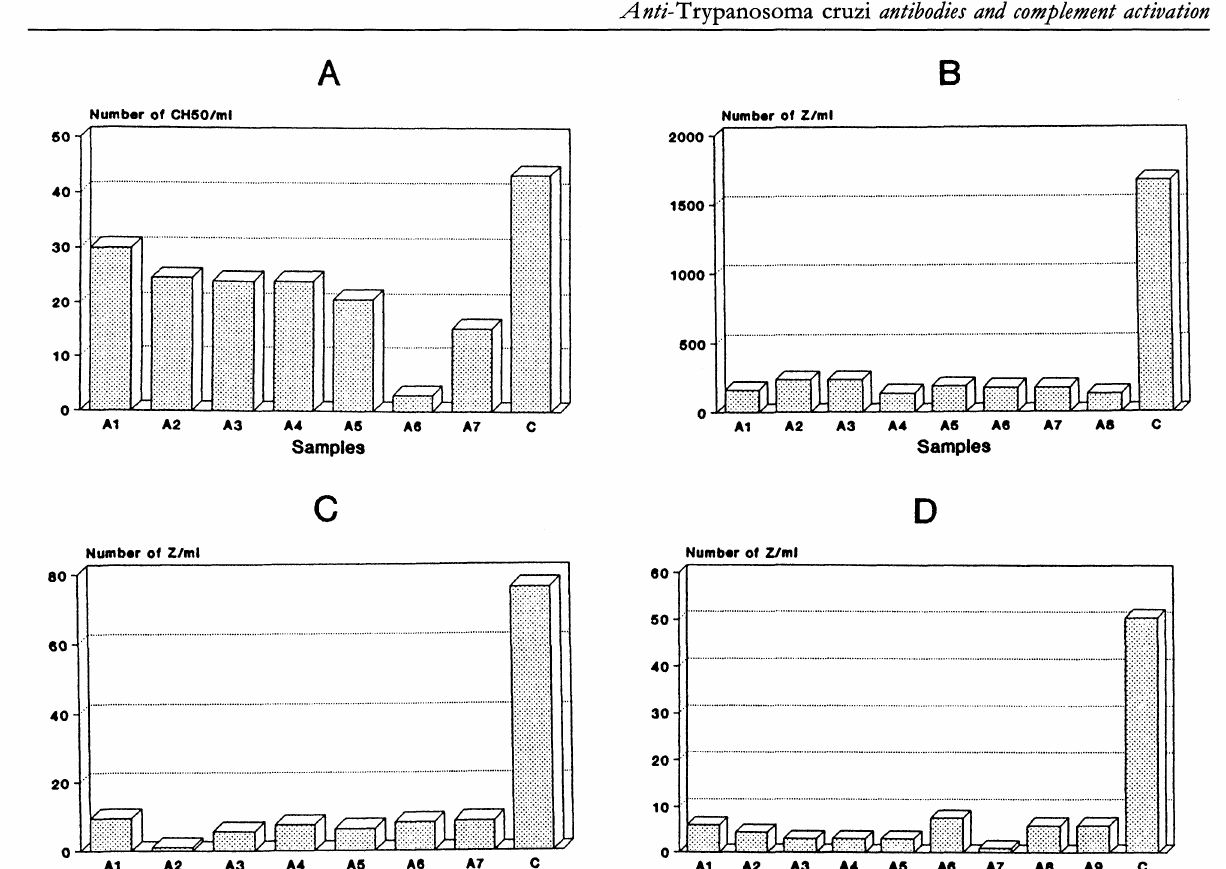
Fig. 1. Activation of human C system in NHS by trypomastigotes (TF) of T. cruzi pre-opsonized with the Abs A1 (IgM, mAb H3G6), A2 (IgM, mAb L1D10), A3 (IgG1, mAb L2B11), A4 (IgG2a mAb 6A2), A5 (IgG1, mAb B10.1), A6 (poly IgG anti-T, cruzl), A7 (total IMS anti-T, cruzl) or with NHS (control-C). Total C consumption was measured by determining the numbers of CHso remaining in the samples of NHS incubated with pre-opsonized TF using sheep red blood cells (E) presensitized with rabbit serum anti-E(EA) in pH 7.4 isotonic veronal buffered saline containing 0.1% gelatin, 15 mM CaCI2 and 5 mM MgCI2 (VBS /) (panel A). The components C4 (panel B) and C3 (panel C) were measured by determining the number of haemolytically active molecules (Z) remaining in the samples of NHS incubated with pre-opsonized TF using EACI or EACI42 intermediate cells, respectively, in VBS factor B in DGVBS containing mM Mg and 10 mM EGTA.